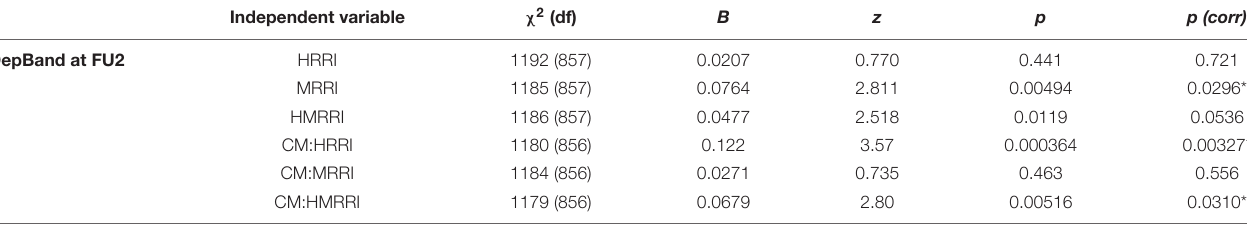
TABLE 1 | Correlations between depression probability (DAWBA score) at age 18 and the genetic scores. Independent variable χ 2 (df)